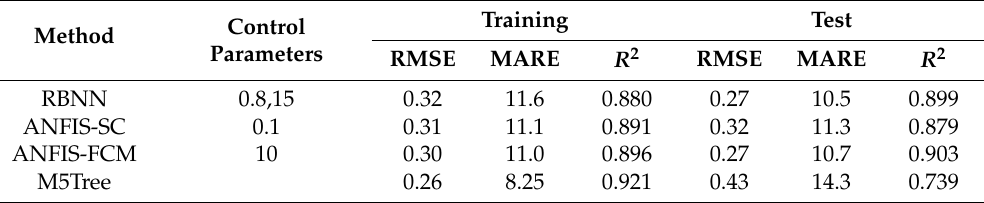
Table 2. Statistical performance of RBNN, ANFIS-SC, ANFIS-FCM and M5Tree models in strength